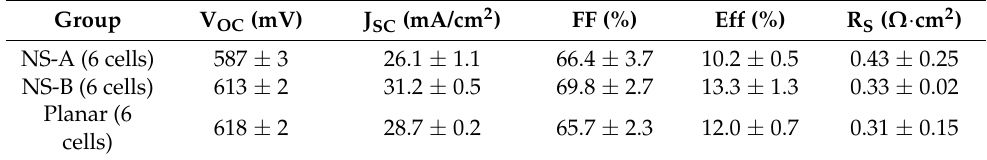
Table 3. Electrical parameters for the silicon nanostructure-textured solar cells after LIP. Group